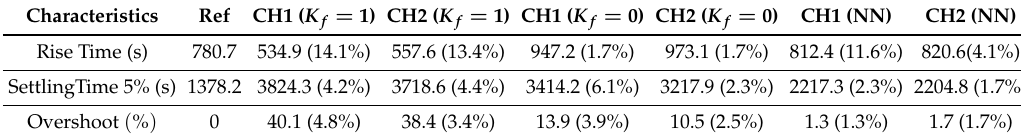
Table 3. Comparison of experimental results for time response characteristics (100 ◦ C to 105 ◦ C). Characteristics